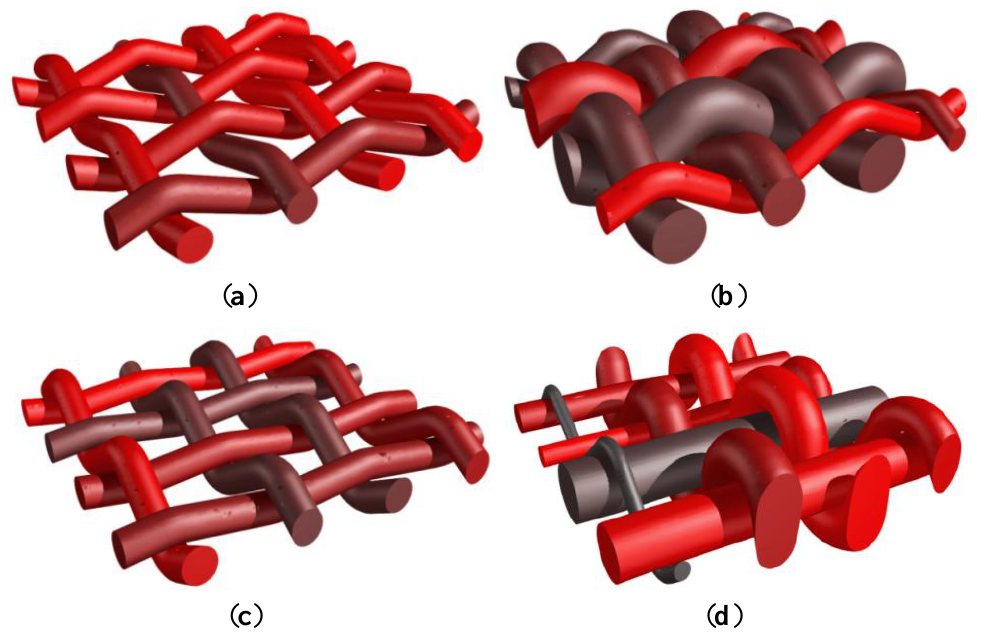
Figure 8. Generation of a reinforcement scheme for a one layer thick weaving. ( a ) Single set of yarns in orthogonal directions with same diameters; ( b ) same weaving scheme as ( a ) with different diameters of yarns; ( c ) same weaving scheme with increase in the tension of one family of yarns; and ( d ) combination of diameter change with fully tensioned yarns.